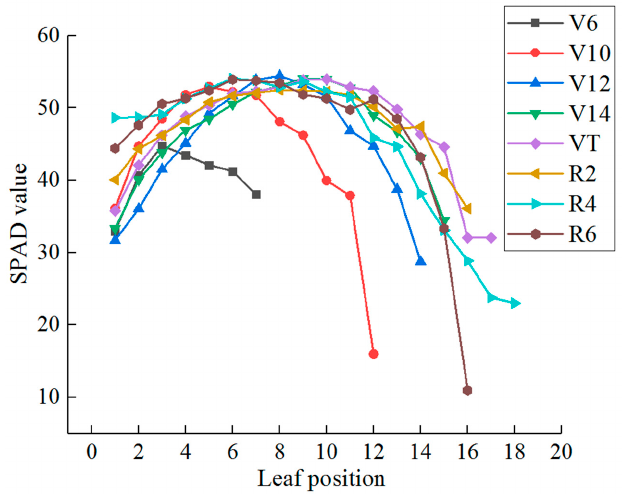
Figure 2. Vertical leaf position soil and plant analyzer development (SPAD) values at different growth stages. distance from the canopy. The vertical distribution of the chlorophyll content at the 1st, 2nd, 3rd, and 4th layers was in agreement with that of the leaf position (Table 2), initially increasing and then decreasing with canopy depth. The chlorophyll contents of the 2nd and 3rd layers was higher than those of the 1st and 4th layers. The 1st, 2nd, and 3rd layers